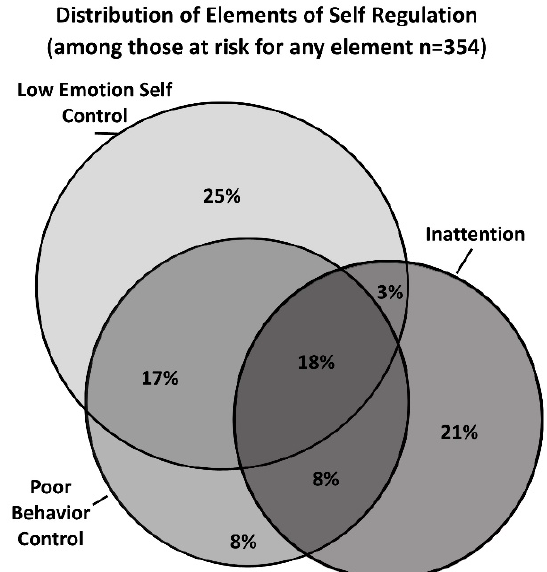
Figure 2. Elements of self-regulation among children who scored at risk on emotional self control, behavior control, or attention scales of the Behavior Assessment System for Children (BASC-2; N =